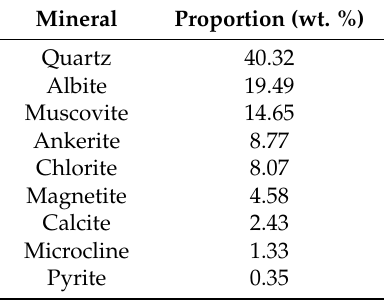
Table 2. Mineralogical composition of the tested Mine A tailings. Mineral Proportion (wt. %)